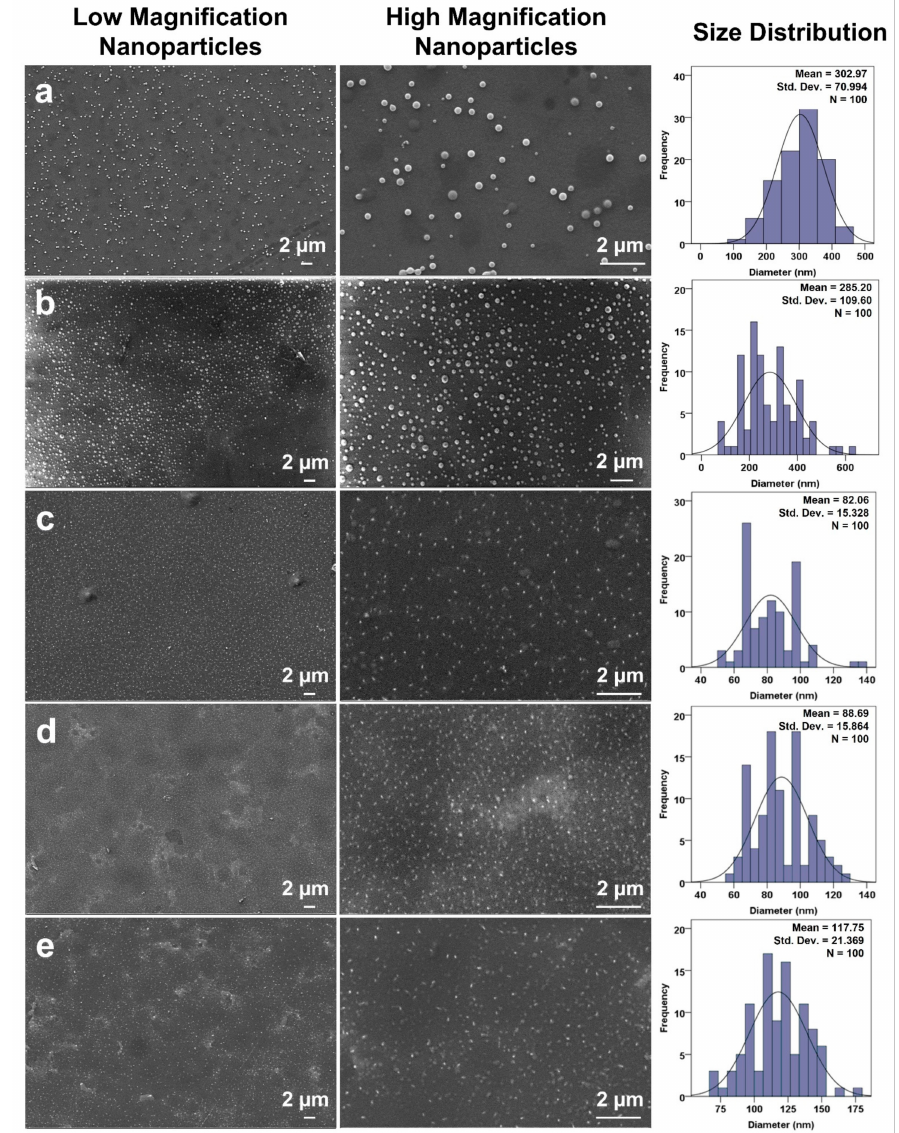
Figure 2. SEM micrographs of prepared nanoparticles at different production conditions and their size distributions. hHL solution was sprayed on ( a ) 8 µ L/min, 18 kV and 10 cm distance, ( b ) 2.5 µ L/min, 18 kV, and 10 cm distance, ( c ) 2.5 µ L/min, 20.5 kV, and 15 cm. ( d ) hHL/0.05RS solution, ( e ) hHL/0.1RS were sprayed on 2.5 µ L/min, 20.5 kV, and 15